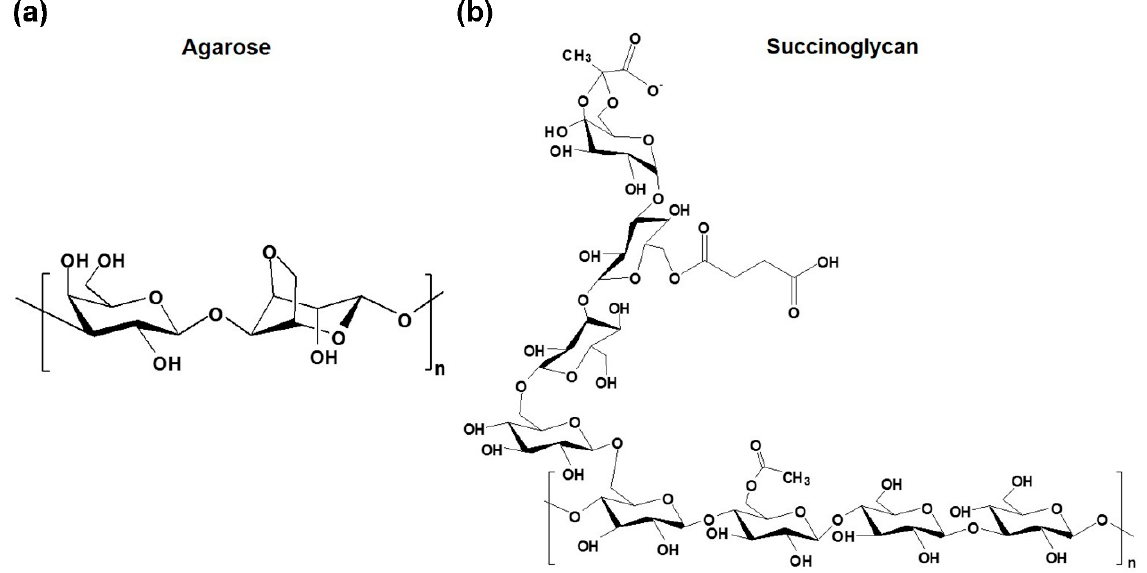
Figure 1. Chemical structures of ( a ) agarose and ( b ) succinoglycan.